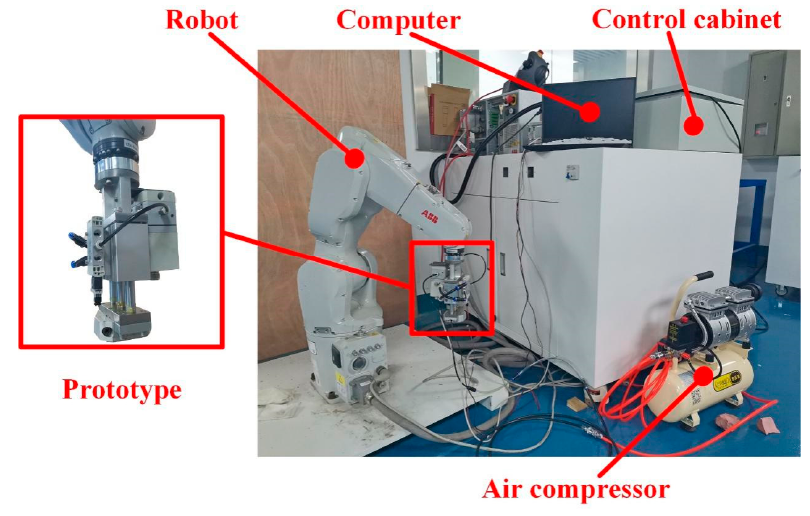
Figure 14. Schematic diagram of the experimental platform.